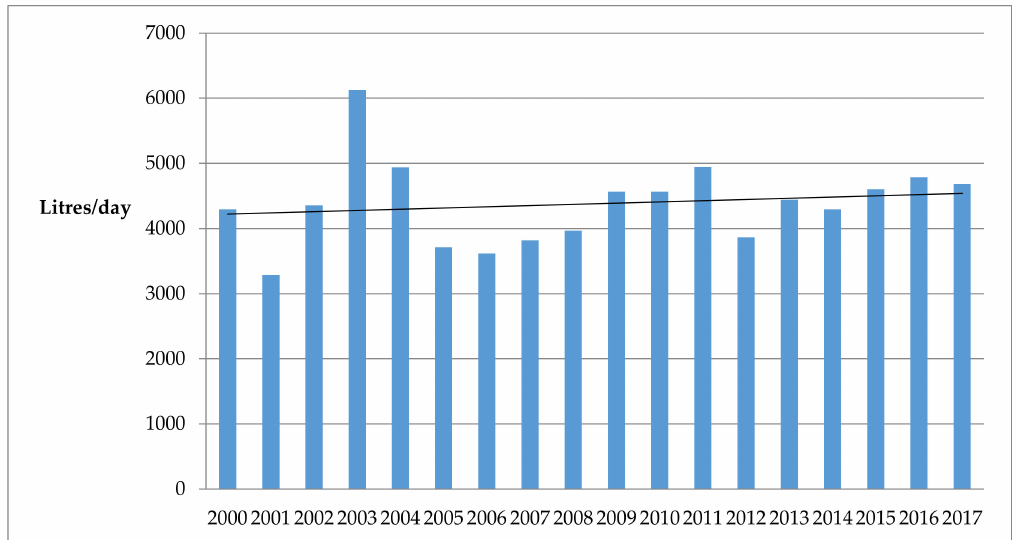
Figure 2. Water consumption in schools (litres / day) (2000–2017). Source: Aguas Municipalizadas de Alicante, Empresa Mixta (AMAEM) [59]. Own